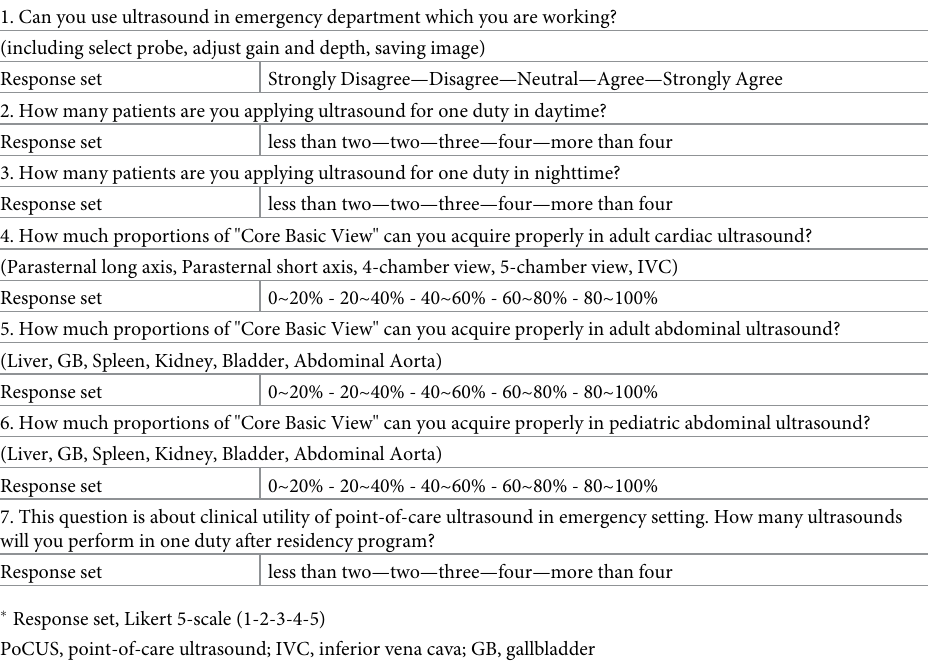
Table 2. Questionnaire for survey of PoCUS